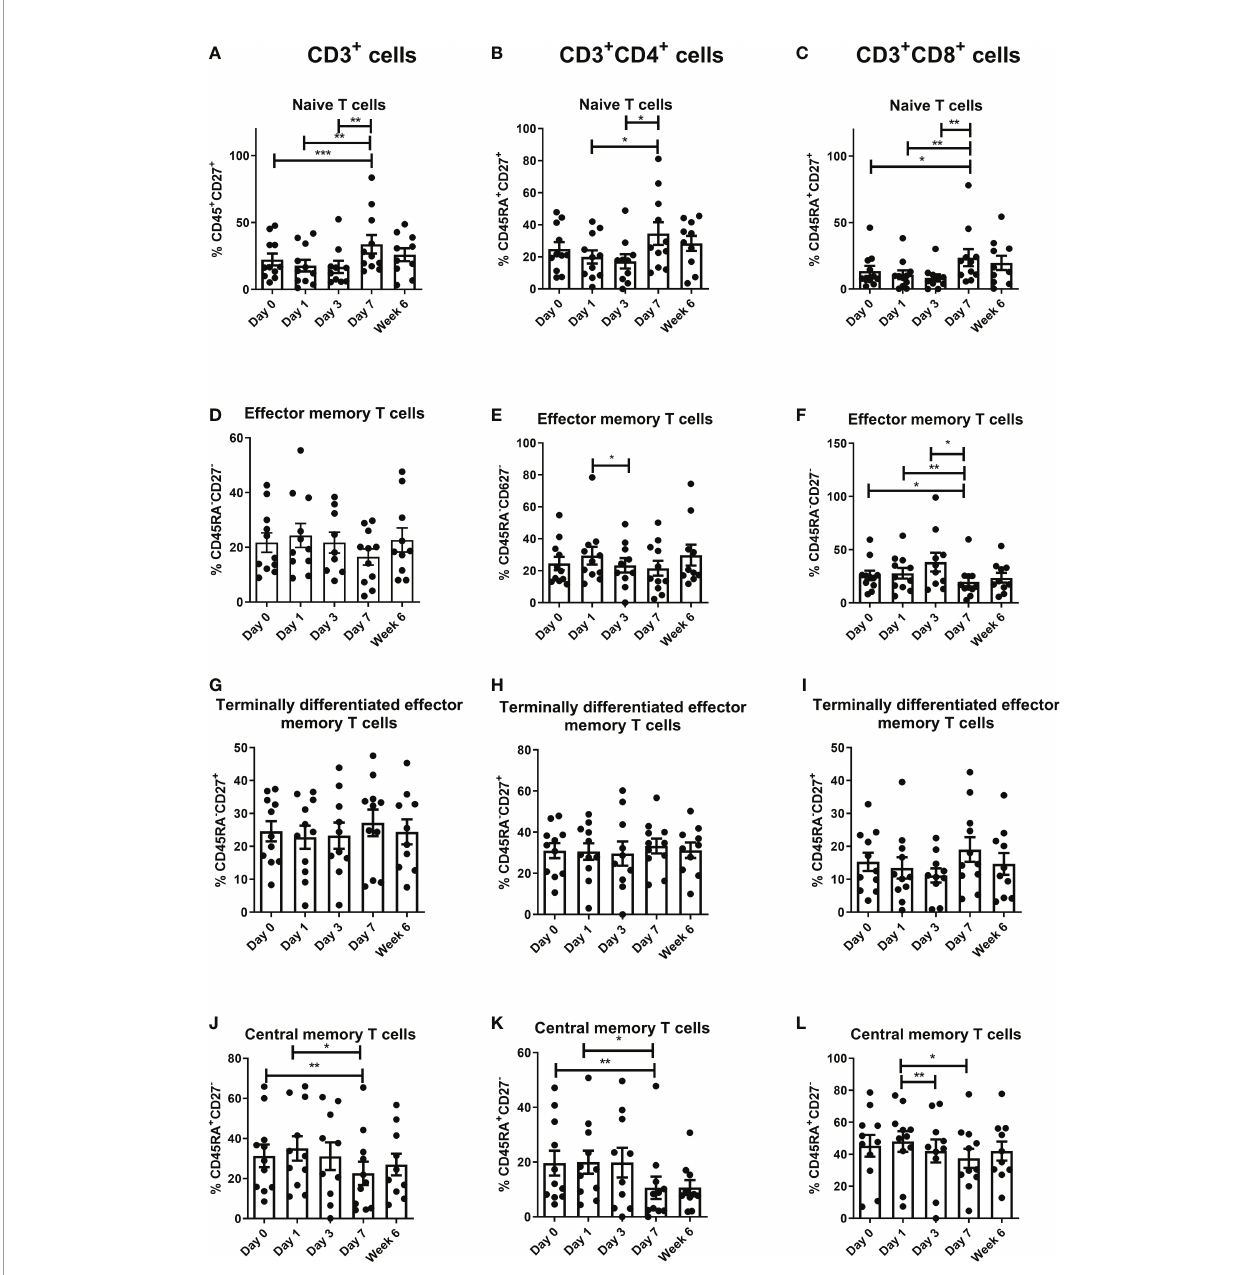
FIGURE 3 | Frequencies of central memory T cells decrease and naïve T cells increase in circulation in the immediate post-operative period. The percentage of peripheral blood naïve [CD45RA + CD27 + (A – C) ], effector memory [CD45RA - CD27 - (D – F) ] terminally differentiated effector memory [CD45RA - CD27 + (G – I) ] and central memory [CD45RA + CD27 - (J – L) ] CD3 + cells, CD3 + CD4 + and CD3 + CD8 + cells in OAC patients was determined on POD 0, 1, 3, 7 and 6 weeks post-surgery by fl ow cytometry (n=11). Paired, non-parametric t-test *p<0.05, **p<0.01 and